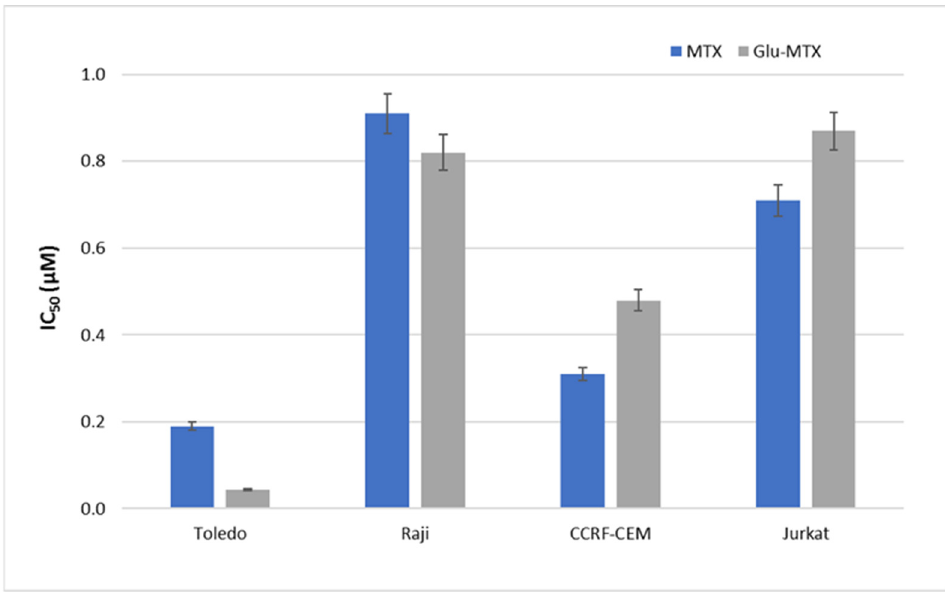
Figure 3. Comparison of IC 50 activity of MTX and Glu–MTX. Incubation time 48 h.